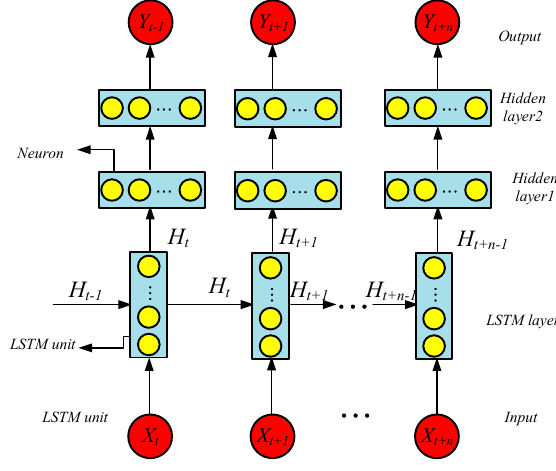
Figure 5. Prediction model of the LSTM.